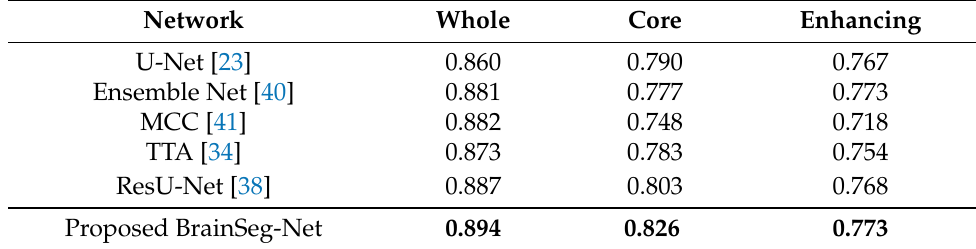
Table 4. Results comparison on the BraTS 2018 validation dataset.